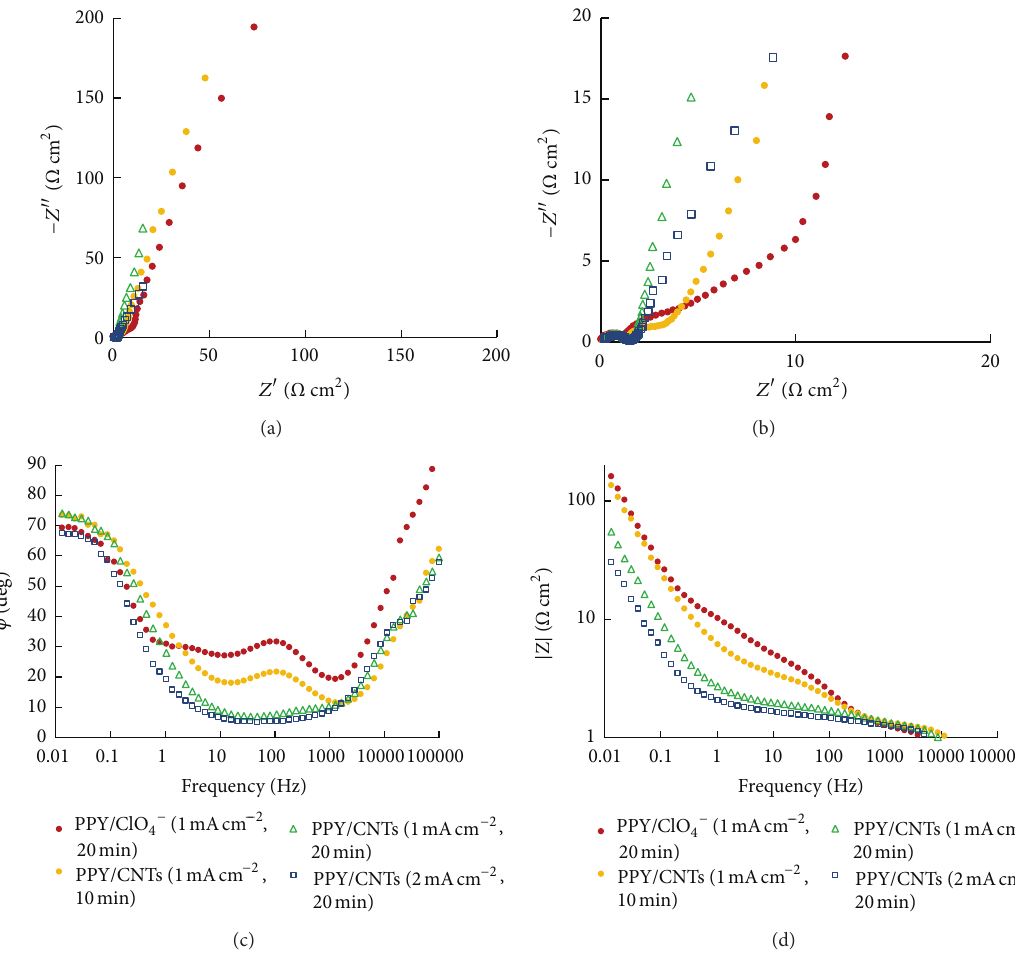
Figure 4: Nyquist ((a)-(b)) and Bode ((c)-(d)) diagrams for PPY/CNTs nanocomposite films compared to the pure polymeric one (obtained galvanostatically at different charge densities) at open circuit potentials in 0.1M LiClO 4 solution in propylene carbonate.